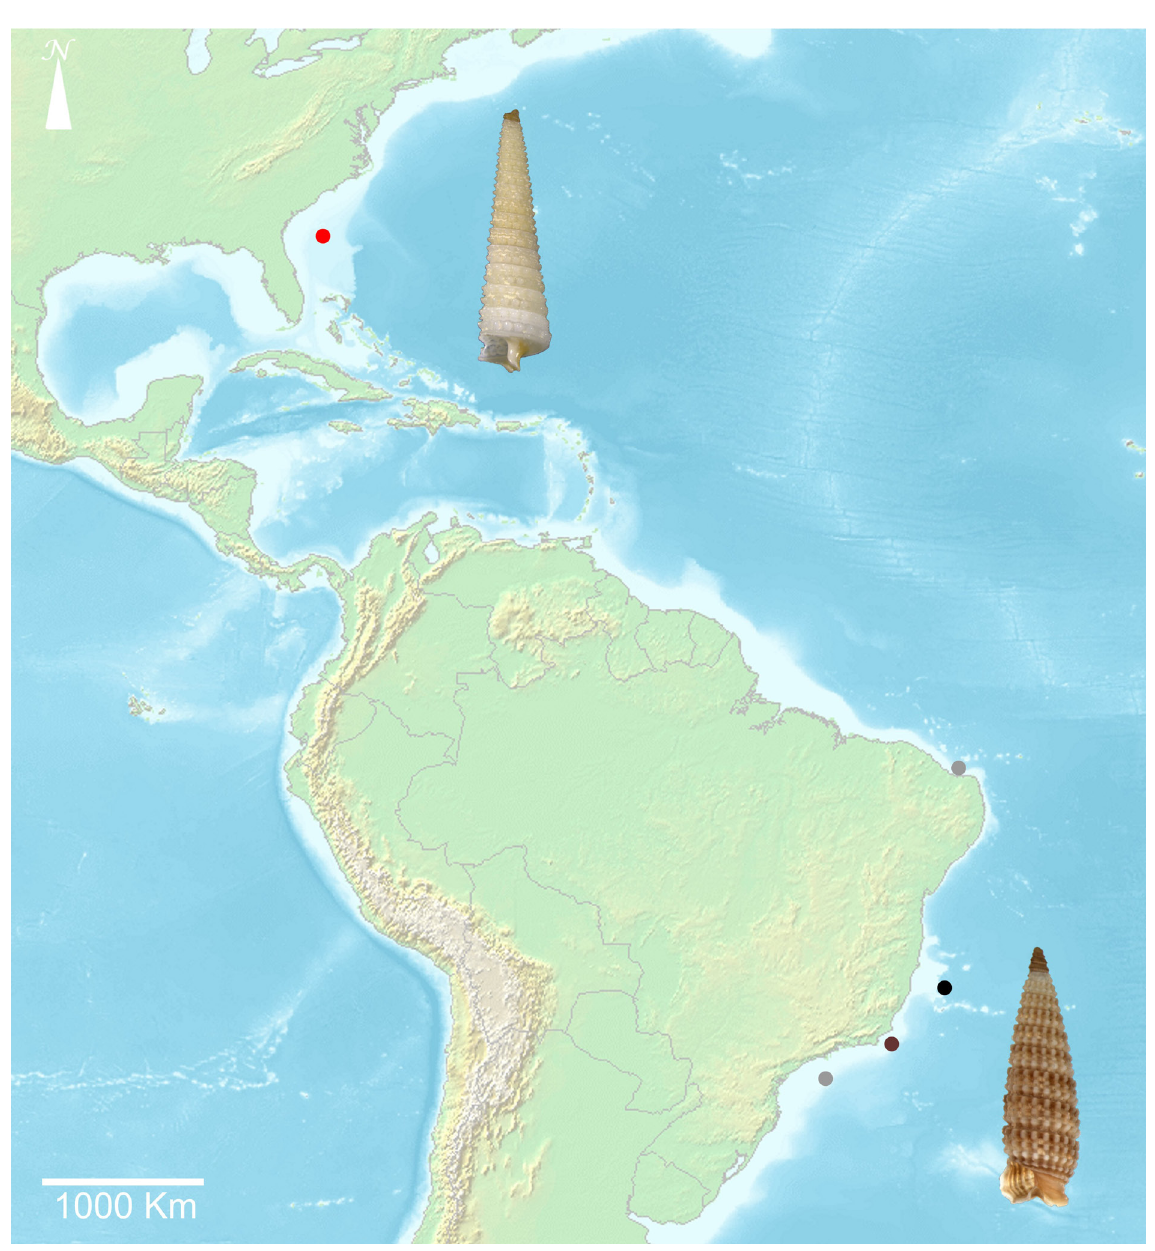
Fig. 57. Distribution map of Monophorus caracca (Dall, 1927) comb. nov. (red circle = type locality; black circle = additional locality) and Monophorus verecundus sp. nov. (brown circle = type locality; gray circles =